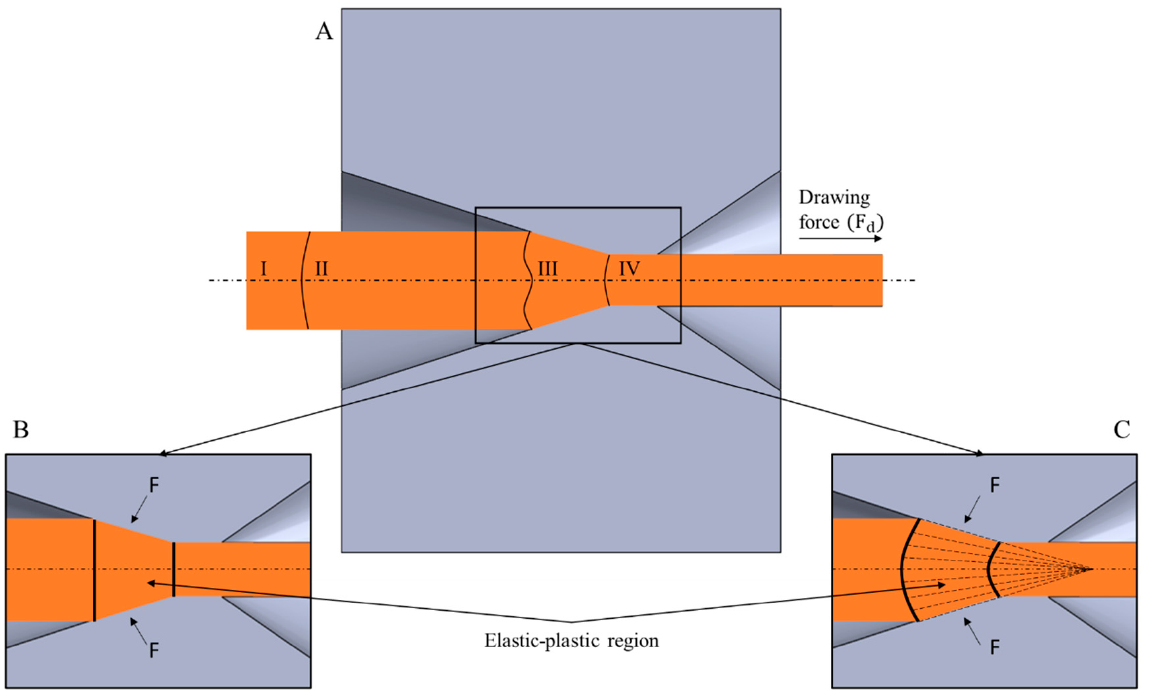
Figure 1. Deformation regions inside of the drawing die ( A )—theoretical analyses of wire drawing process (classical approach): ( B ) the flat cross-section hypothesis (homogenous deformation); ( C ) the spherical boundary hypothesis (upper-bound approach); based on [10]. Reproduced with permission from Knych, Elastic and Plastic Strains in Drawn Circular Sections; Uczelniane Wydawnictwa Naukowo-Dydaktyczne: Kraków, Poland, 2001.